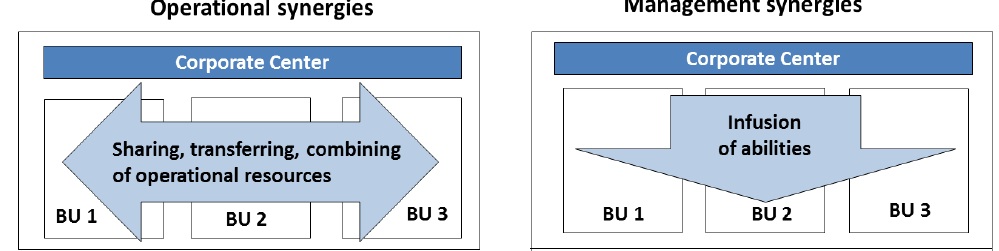
Figure 4. Categorization of synergy types. Own illustration, based on [10] (p. 354). As indicated before, the focus of this categorization lies on the potential gain of value on the corporate level of a multi-business firm. Therefore, in this overview, the corporate center is shown overhead of three exemplary business units (BUs). Müller-Stewens and Brauer [10] (p. 354) refer to BUs as strategic ones. Every BU, therefore, represents a certain functional unit. The arrows in the chart show the direction of information or resources flow for the respective synergy types.